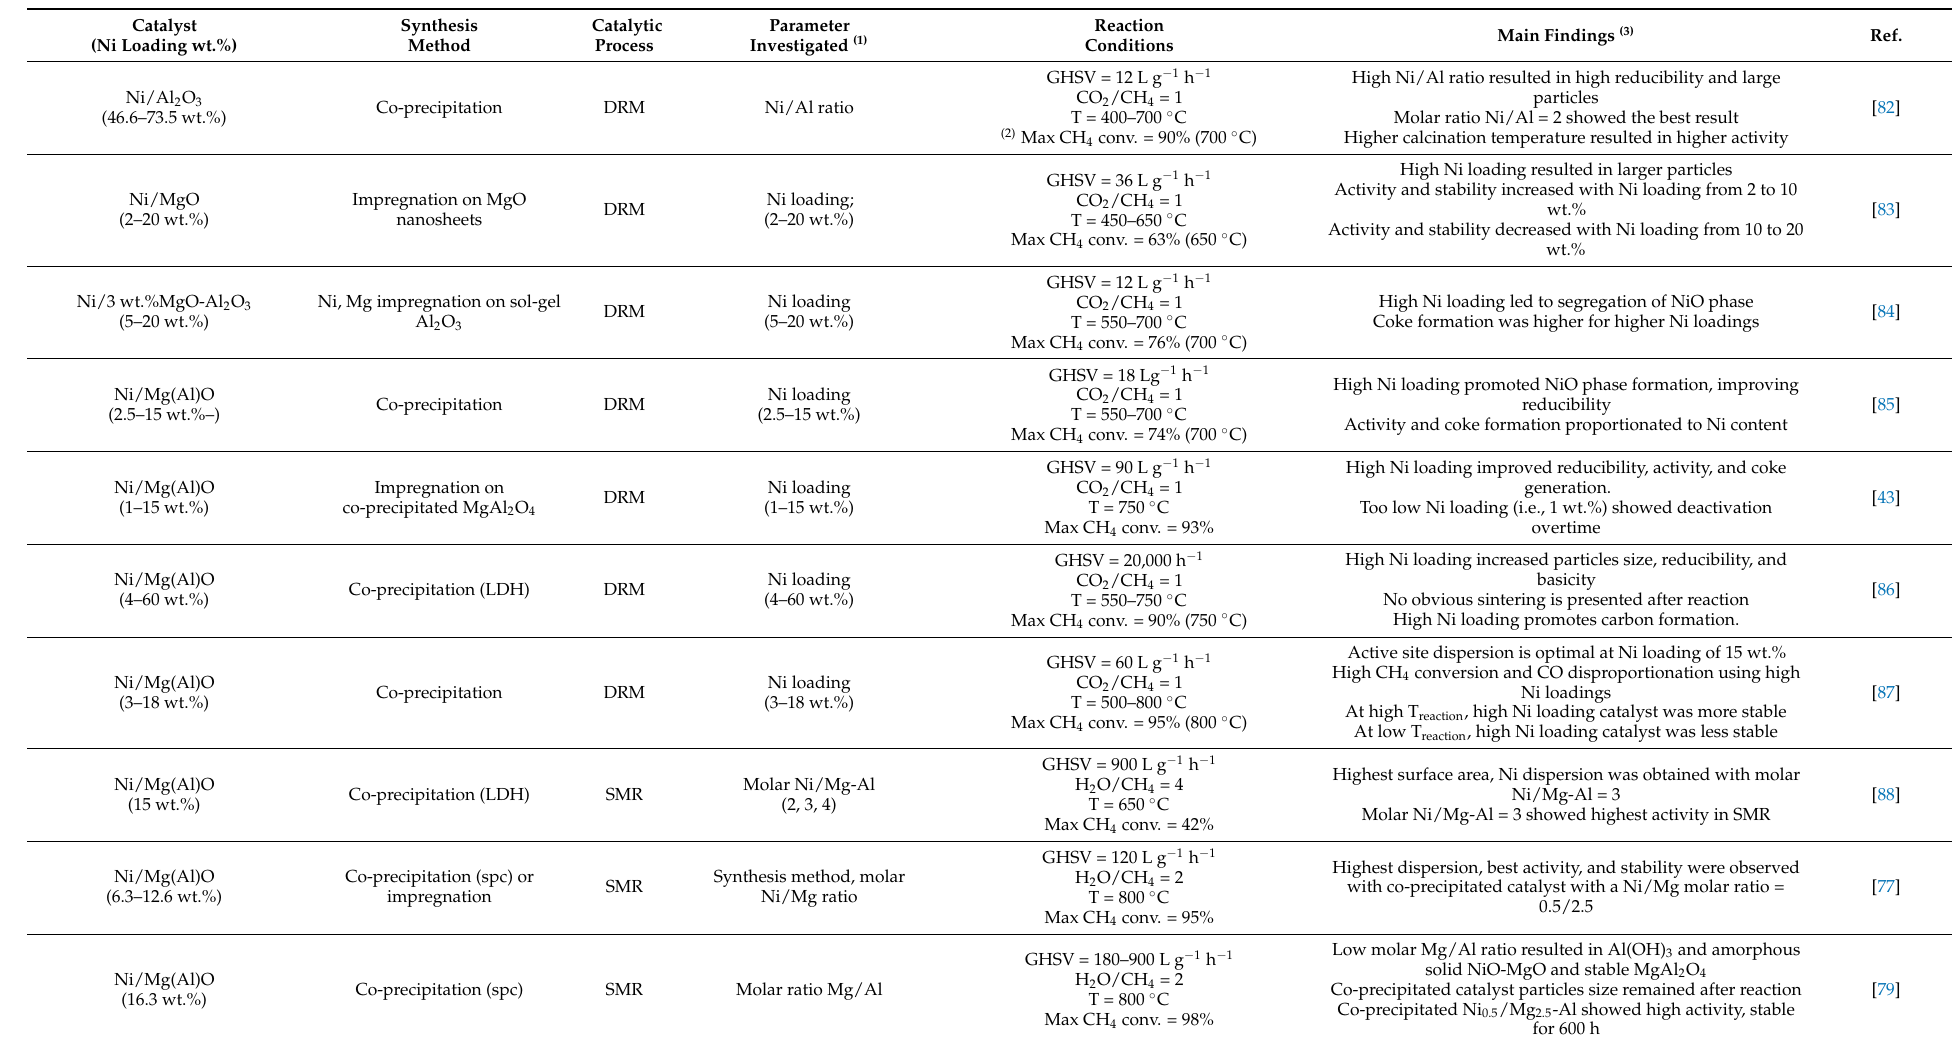
Table 2. Monometallic Ni catalysts supported on Mg(Al)O obtained by co-precipitation and impregnation methods for SMR and